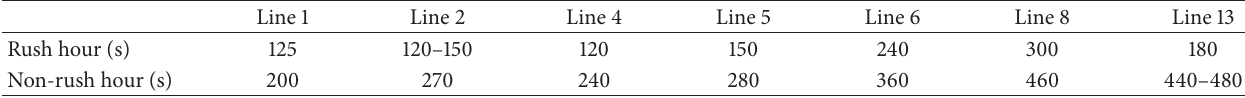
Table 5: Headways of Line 2 and feeder lines.